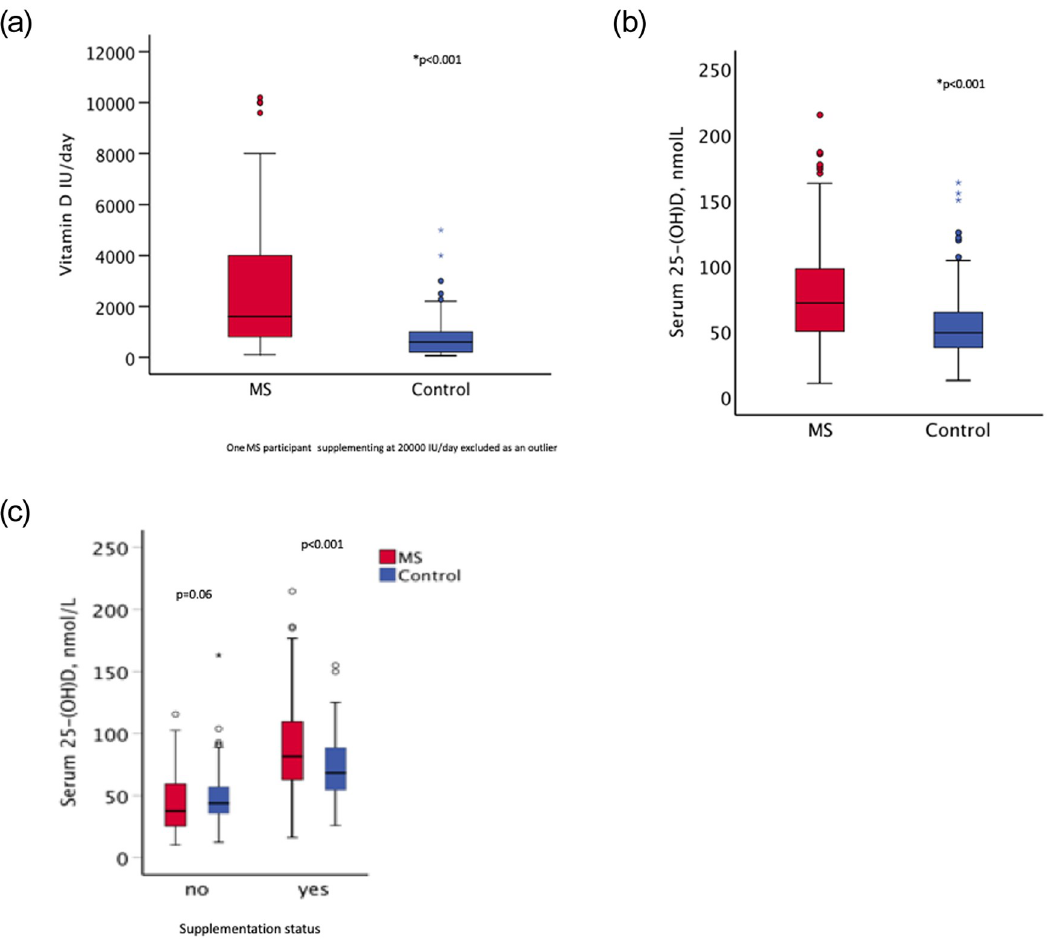
Fig 2. Vitamin D supplementation dose and serum 25(OH)D levels in MS and control participants. (a) Distribution of dose (IU/ day) of vitamin D amongst those MS (n = 238) and control (n = 63) that take supplements. (b) Serum 25(OH)D levels (nmol/L) of MS (n = 321) and control (n = 261) participants. (c) Serum 25-(OH)D levels of MS and control split by Vitamin D supplementation status.